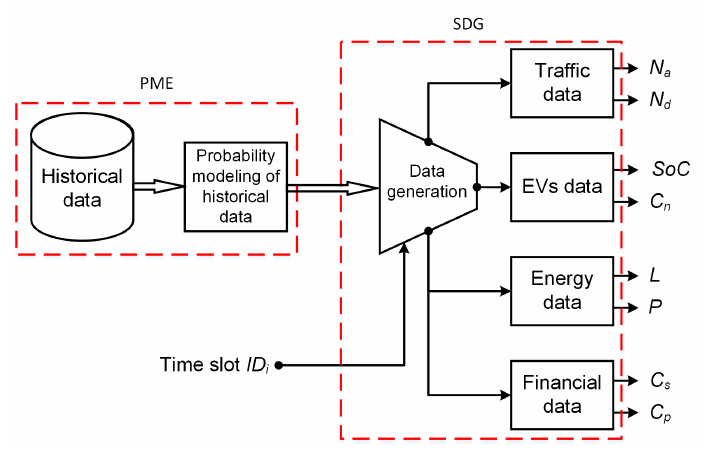
Figure 2. The components of the data simulator.